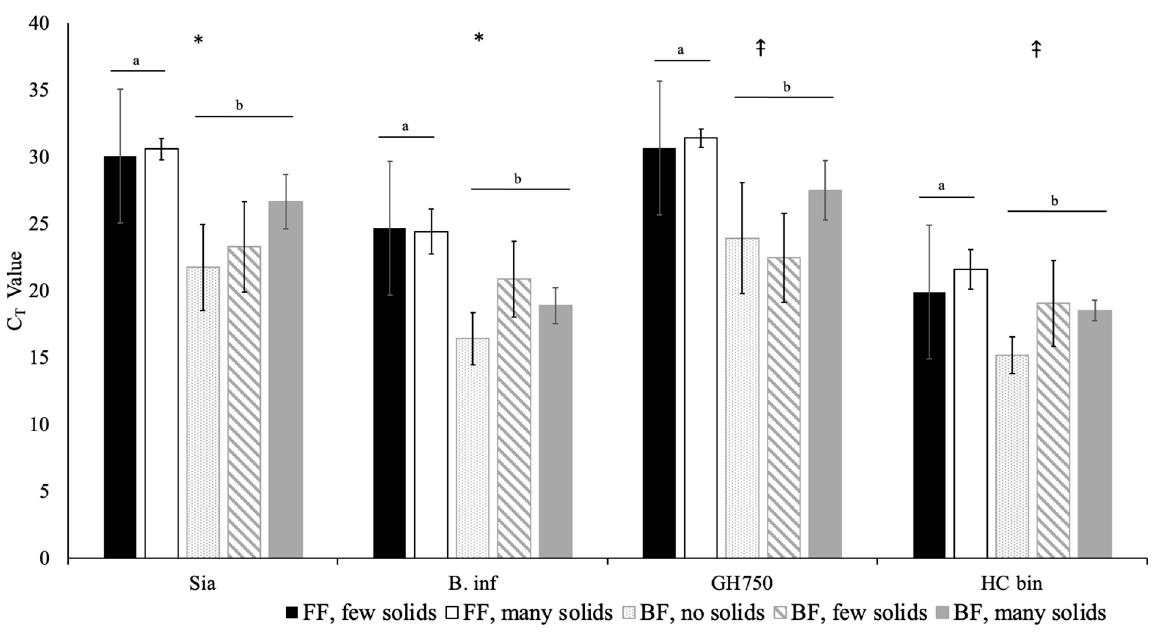
Figure 3. The abundance of each gene (displayed as the C T value) whether the infants were formula-fed (FF) or breastfed (BF) and the amount of solids that the infants consumed (no solids, few solids, many solids). Solid food intake was not significantly associated with the abundance of any gene. For Sia and B. inf, one is still able to determine if the infants consumed human milk as part of their diets, even once they start eating solid foods. Note that the higher the C T value, the lower the gene abundance. The data are means ± SD; * p < 0.05; ⤉ p < 0.10. Within a gene, the bars that do not share a letter differ significantly from each other.